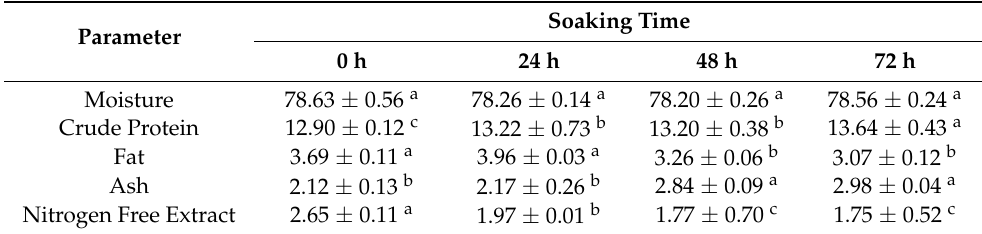
Table 4. Carcass proximate analysis (%) of African catfish Clarias gariepinus fed soaked Jatropha curcas kernel-based diets.